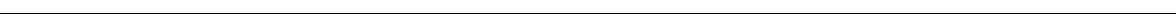
Fig. 2 Differences in TF binding intensities strongly affected by variation acting in cis and are additively inherited. a Mean F0 vs. F1 TF binding intensity ratios (BL6 vs. CAST) for CEBPA are plotted in the left panel. The right panel shows mean F0 vs. F1 gene expression ratios for liver-expressed protein-coding genes 35 . The correlation coef fi cient re fl ects the extent of cis -directed regulatory mechanisms. b Proportion of CEBPA binding locations at promoters and enhancers. The width of the bar is proportional to the overall number of TFBSs in the “ All ” category. Binomial tests were used to test for enrichment at promoters and enhancers for each regulatory class based on the overall numbers of TFBSs ( “ All ” ). *** P < 0.0001, ** P < 0.001,* P < 0.05. c Most allele-speci fi c TFBSs are affected by variation acting in cis . Lineage-speci fi c TFBSs were de fi ned as TFBSs where binding occurs either in BL6 or CAST in F0 individuals and in an allele-speci fi c manner in F1 individuals based on a cut-off (F0 B6/(B6+CAST) > 0.95, F1 B6/(B6+CAST) > 0.95, F0 B6/(B6+CAST) < 0.05, F1 B6/(B6+CAST) < 0.05). These TFBSs can be sorted into the three categories described. d Mean CEBPA log2 F0 total read counts were plotted against mean log2 F1 read count (BL6+CAST allele) multiplied by 2. For the scatterplot, we used averages across biological replicates. TFBSs affected by variation acting in cis are thus expected to fall along the diagonal and these have been colored blue (see c ). Categories shown were determined by maximal likelihood estimation. e The majority of cis -directed TFBSs are inherited additively. TFBSs affected by variation acting in trans may show additive or dominant inheritance patterns in TF binding intensities. Different modes of inheritance were de fi ned by comparing overall peak binding intensities between F0 and F1 individuals. Total F1 counts were individually scaled to 1 (yellow). Red indicates TFBSs where F1 > F0; blue indicates TFBSs where F1 < F0. CEBPA data are